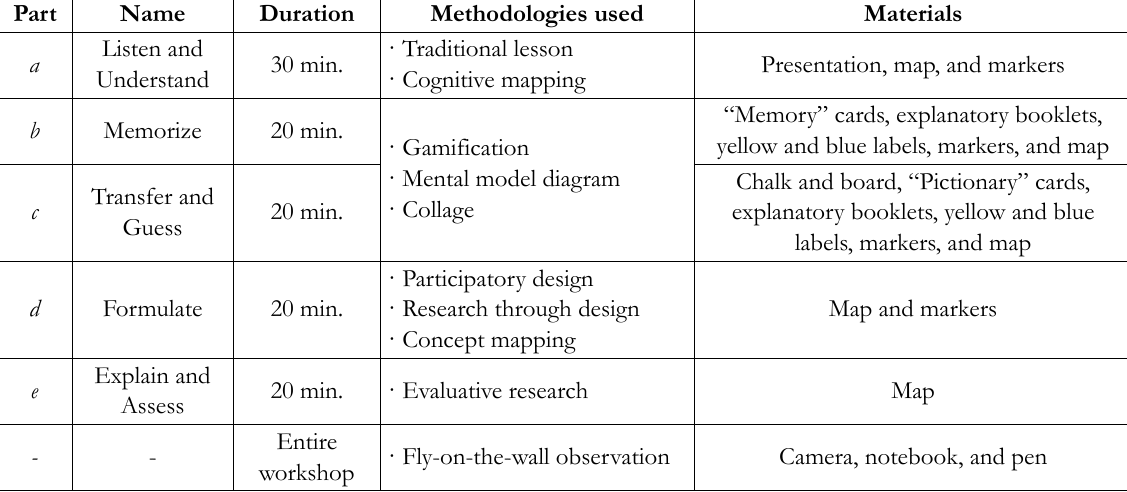
Table 2. Educational toolkit based on design methodologies to